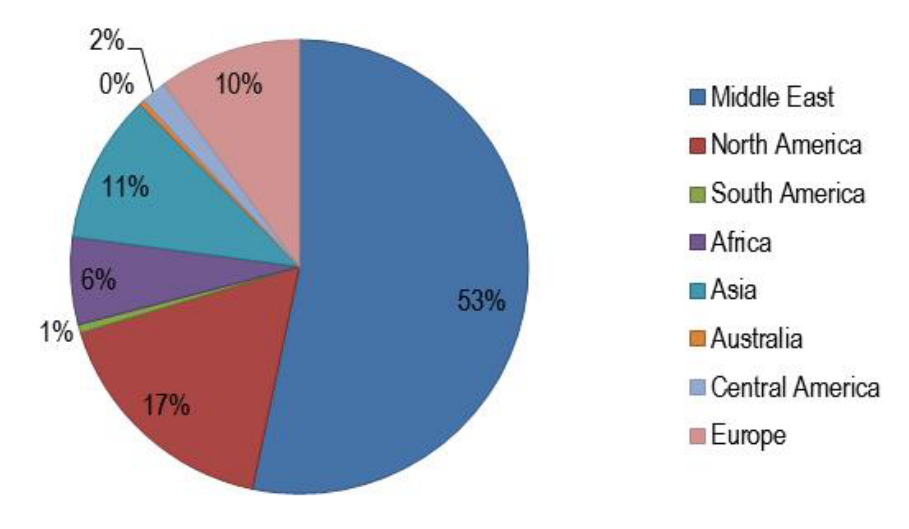
Figure 1. World desalination plants per geographical area (%). Adapted from [10].